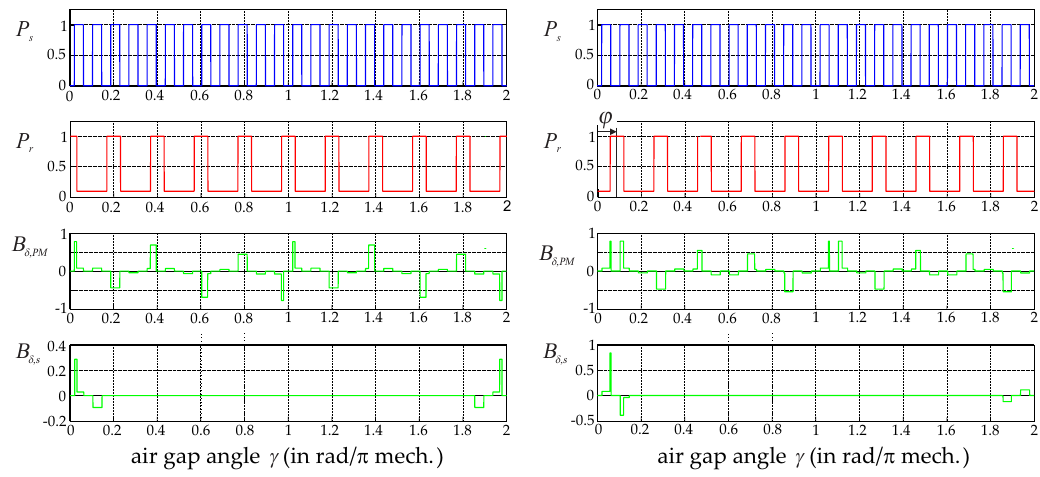
Figure 4. Normalized permeances and air gap flux densities of the flux-switching motor for mechanical rotor angles φ of 0 ◦ ( left ) and 16 ◦ ( right ).